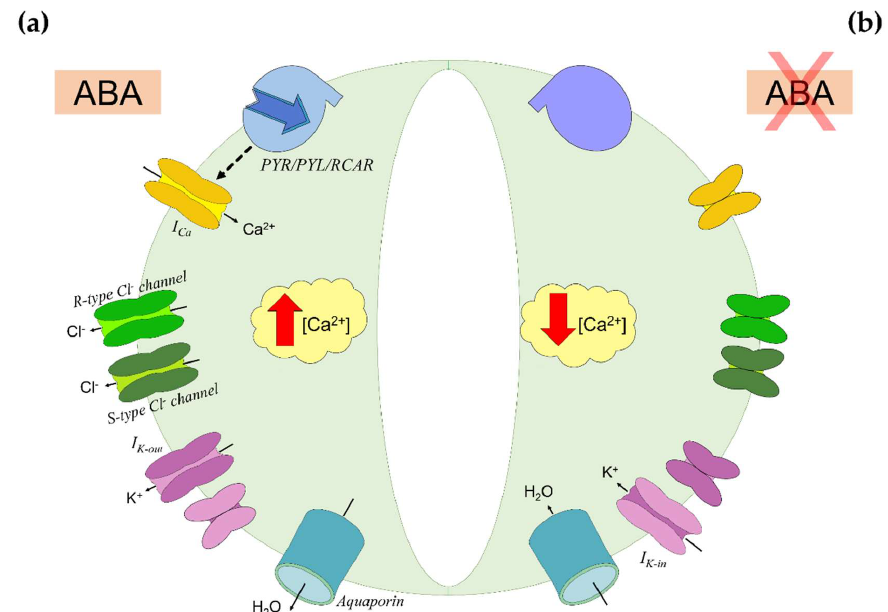
Figure 2. Abscisic acid (ABA) signaling in guard cells. ( a ) ABA inducing stomatal closure. ABA binds to PYR/PYL/RCAR receptors on the guard cells membrane and triggers the accumulation in cytosol of Ca 2+ by activation of Ca 2+ channels (I Ca ). Under elevated Ca 2+ concentration ([Ca 2+ ]), the cell-efflux of Cl − is enhanced. This efflux is mediated by rapid transient (R-type) and slow-activating sustained (S-type) Cl − channels, and it causes plasma membrane depolarization. Thence, the K + uptake is downregulated by inward-rectifying K + channels (I k-in ) activity, while the K + efflux is promoted through outward-rectifying K + channels (I k-out ). The overall reduction in ions content triggers water efflux through aquaporins by osmosis, causing loss of turgor in guard cells and stomatal closure. ( b ) Stomatal reopening by ABA inactivation. As ABA does not bind further to PYR/PYL/RCAR receptors, Ca 2+ accumulation ceases. The osmotic balance is restored by K + uptake through I k-in , promoting water uptake and reacquiring turgidity. Based on [56].